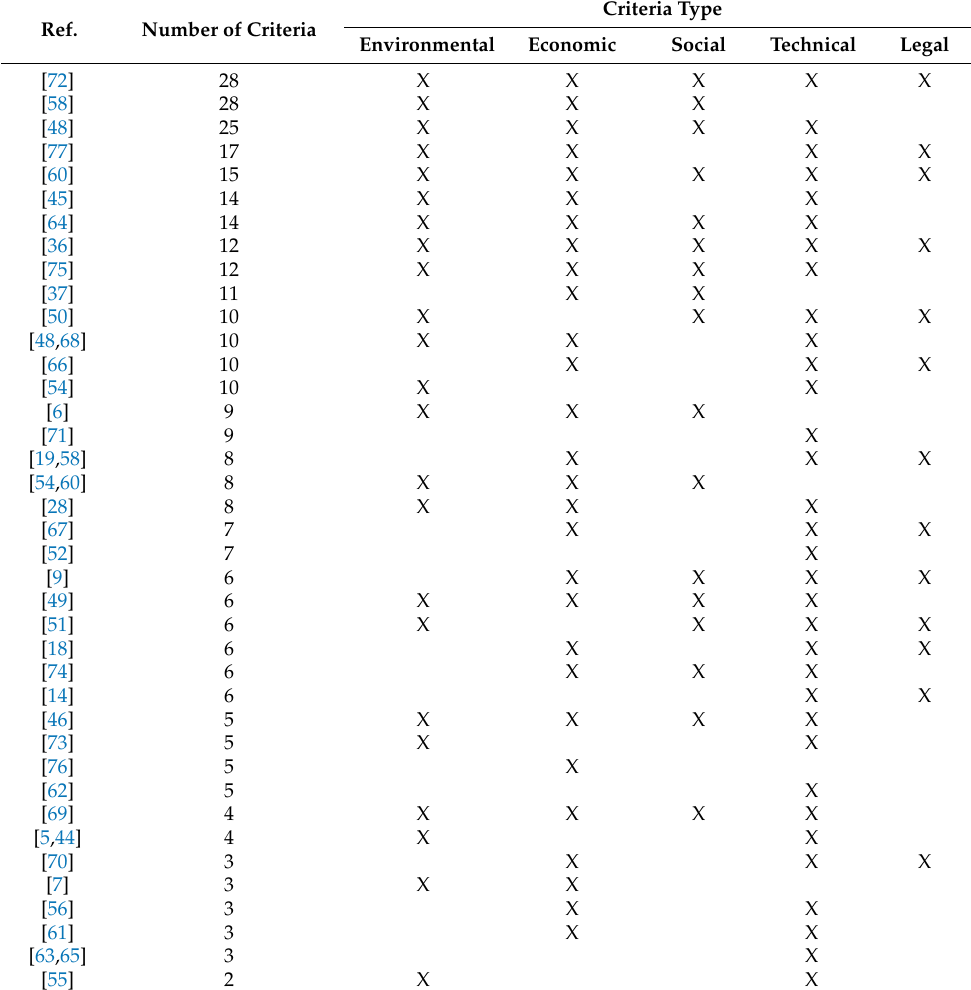
Table 7. Number and type of criteria used in the decision making phase.